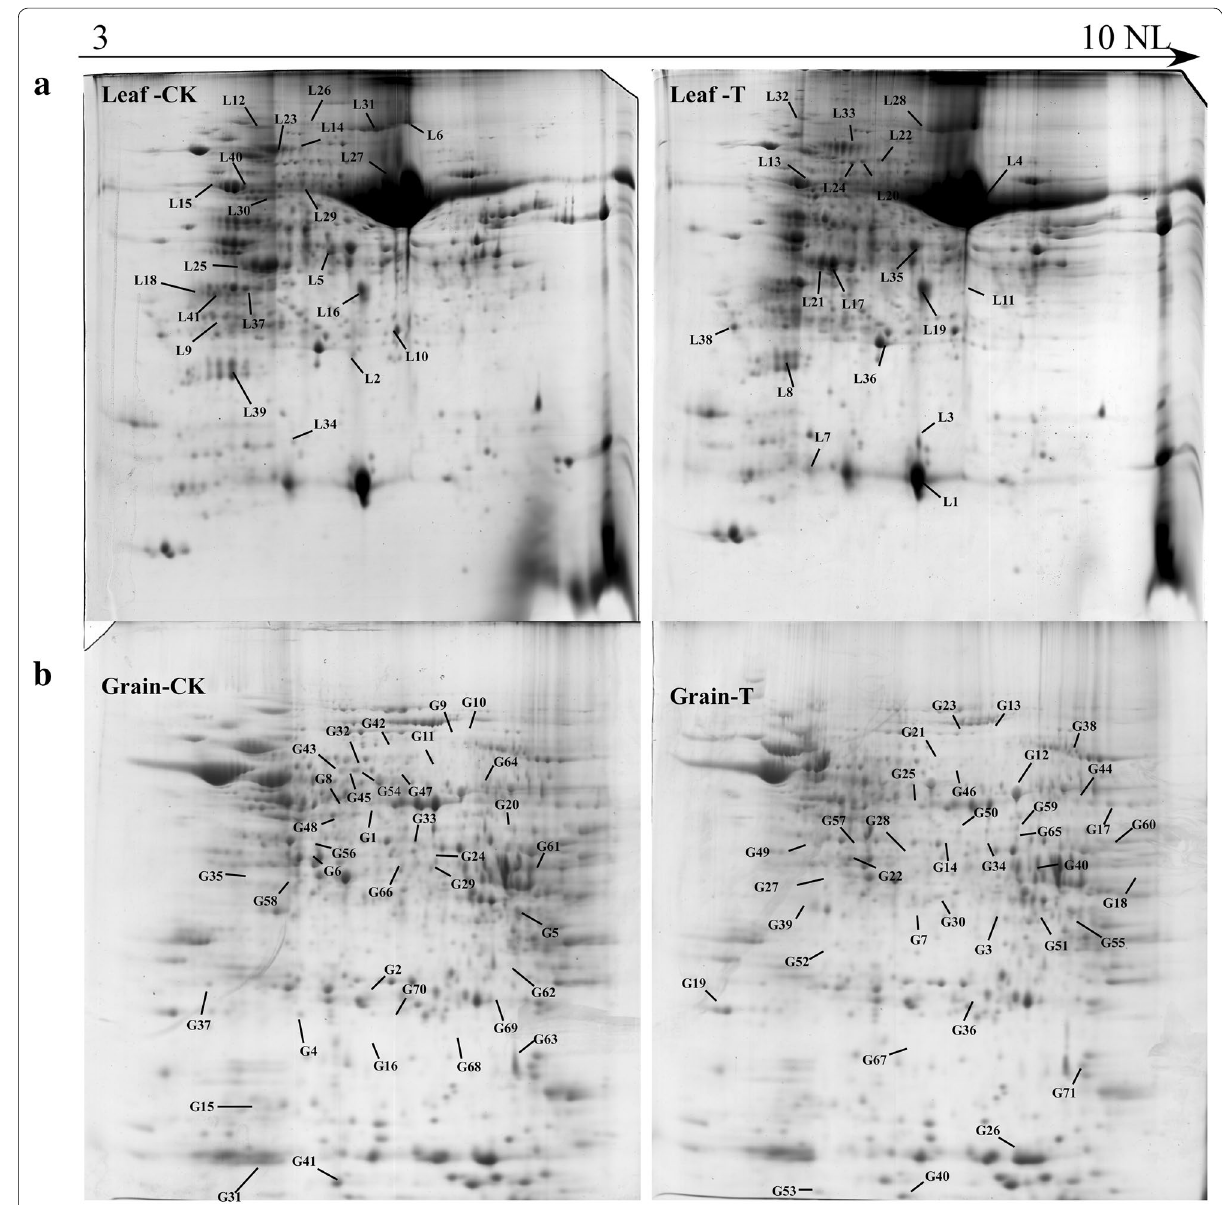
Fig. 3 2-DE gel images of flag leaves and developing grains at 20 DPA in Zhongmai 175 under drought stress. a Flag leaf 2-DE gels of CK and drought treatment. b Grain 2-DE gels of CK and drought